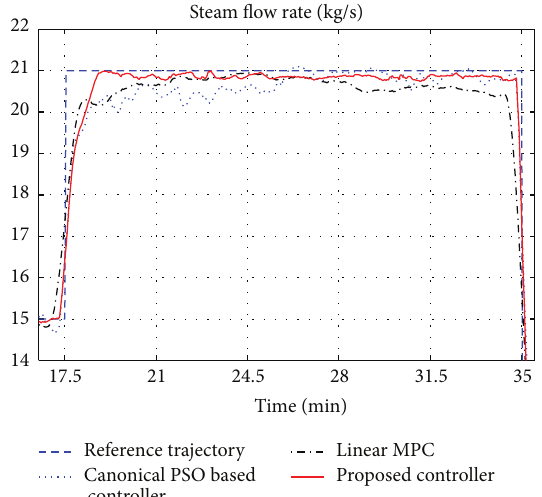
Figure 8: Zoomed area between the instants 17.5 and 35 min of the steam flow